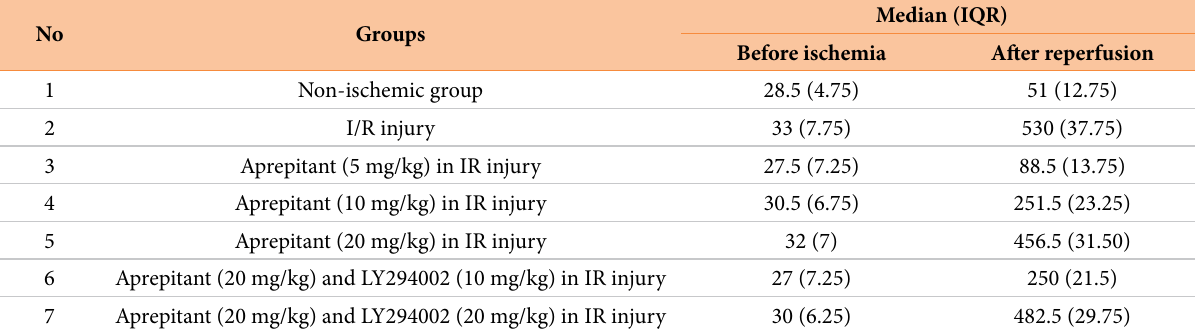
Table 1 - Values of LDH-1 in median (IQR) in aprepitant and LY294002 treated animals in ischemia-reperfusion induced injury.